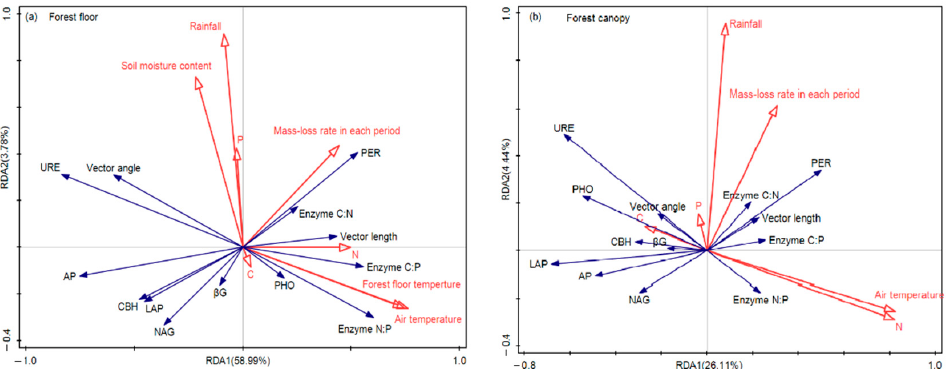
Figure 5. The redundancy analysis (RDA) for enzyme activity, enzyme stoichiometry, enzyme vector features, environmental factors, and litter mass-loss rate in each period in the forest canopy and forest floor. (a) Forest floor, (b) Forest canopy. β G: β -1,4-glucosidase, CBH: β -D-cellobiosidase, PER: peroxidase, PHO: polyphenol oxidase, LAP: L-leucine aminopeptidase, NAG: β -1,4-N-acetylglucosaminidase, URE: urease, AP: acid phosphatase; Enzyme C:N, ln β G:ln(NAG + LAP); Enzyme C:P,